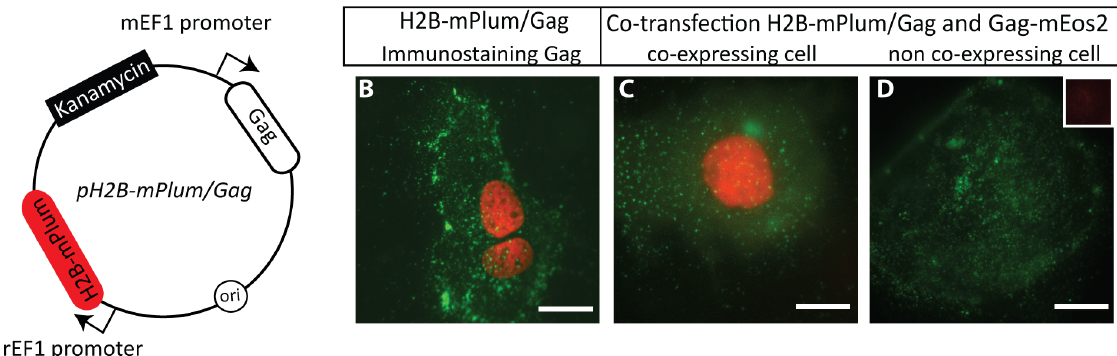
Figure 1. Visualization of unlabeled Gag expression in single cells. ( A ) Plasmid map of pH2B-mPlum/Gag ( B ) Wide-field images of Cos7 cells transfected with the pH2B-mPlum/Gag vector and immunostained against Gag (Alexa Fluor 488). The nuclear H2B-mPlum reporter protein (red) and Gag (green) are always present in conjunction. ( C ) Cells co-transfected with a mixture of pH2B-mPlum/Gag and pGag-mEos2 at an equimolar ratio. Image of H2B-mPlum (red) and Gag-mEos2 (green) of a typical cell expressing both constructs. ( D ) Cells co-transfected with a mixture of pH2B-mPlum/Gag and pGag-mEos2 , image of a cell expressing only Gag-mEos2. The inset shows the fluorescence detected in the red channel, which is at the background level. Scale bars correspond to 5 m